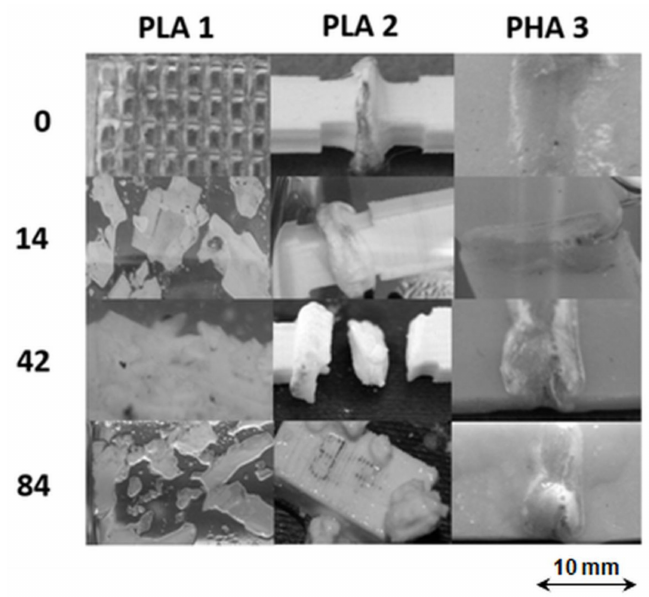
Figure 6. Photographs of welded samples before (0) and after 14, 42 and 84 days of incubation in water at 70 ◦ C.